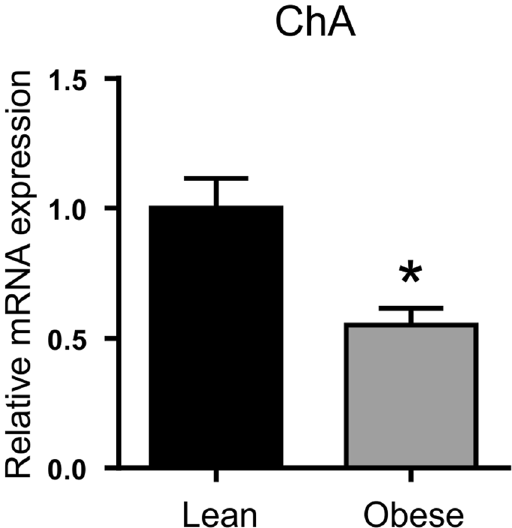
Figure 2. Expression profile of chromogranin A mRNA in duodenal biopsies. Relative mRNA abundance in lean ( ■ ) and obese ( ) duodenum for ChA (enteroendocrine cell marker) determined by qPCR. Values are means ± SEM, normalised to RNA polymerase IIA (POLR2A) m RNA expression, n = 4. Statistical significance was determined by a Student’s t -test where * p <